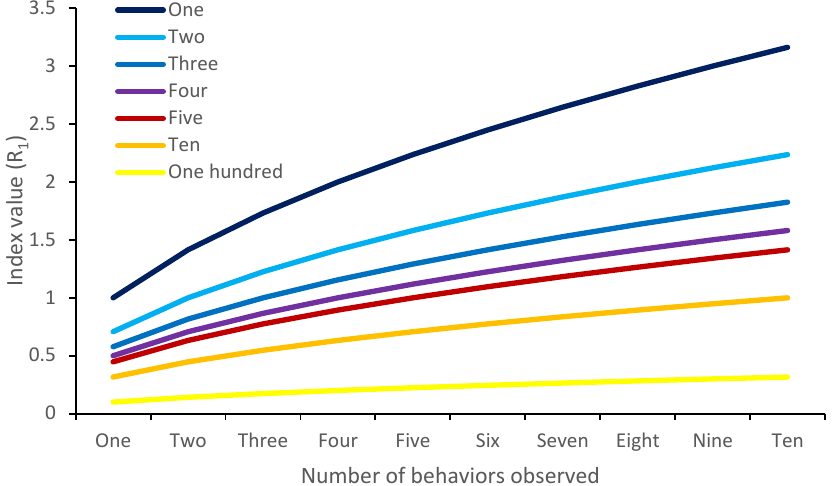
Figure 5. Menhinick’s index values when each behavior is seen equally at a rate of one, two, three, four, five, ten or one hundred times in an observation period.